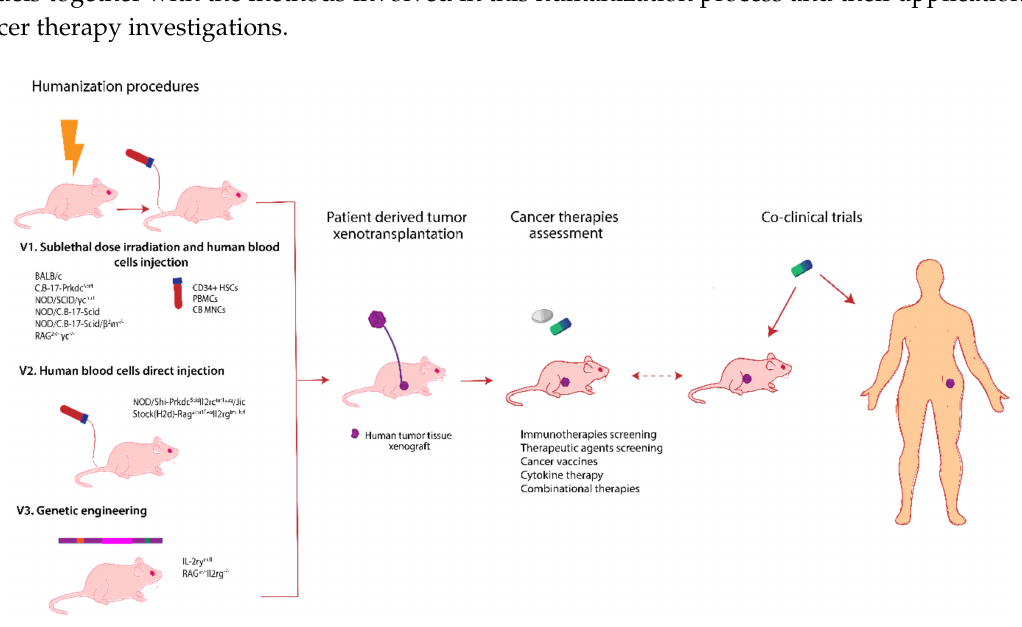
Figure 3. Humanized mice models development and their application in personalized cancer therapy. There are various mouse strains that can be engaged in obtaining avatar mouse